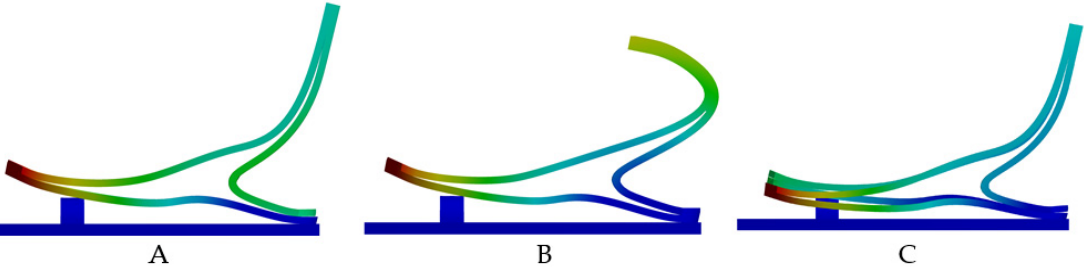
Figure 17. Results of deformations on uneven terrain.